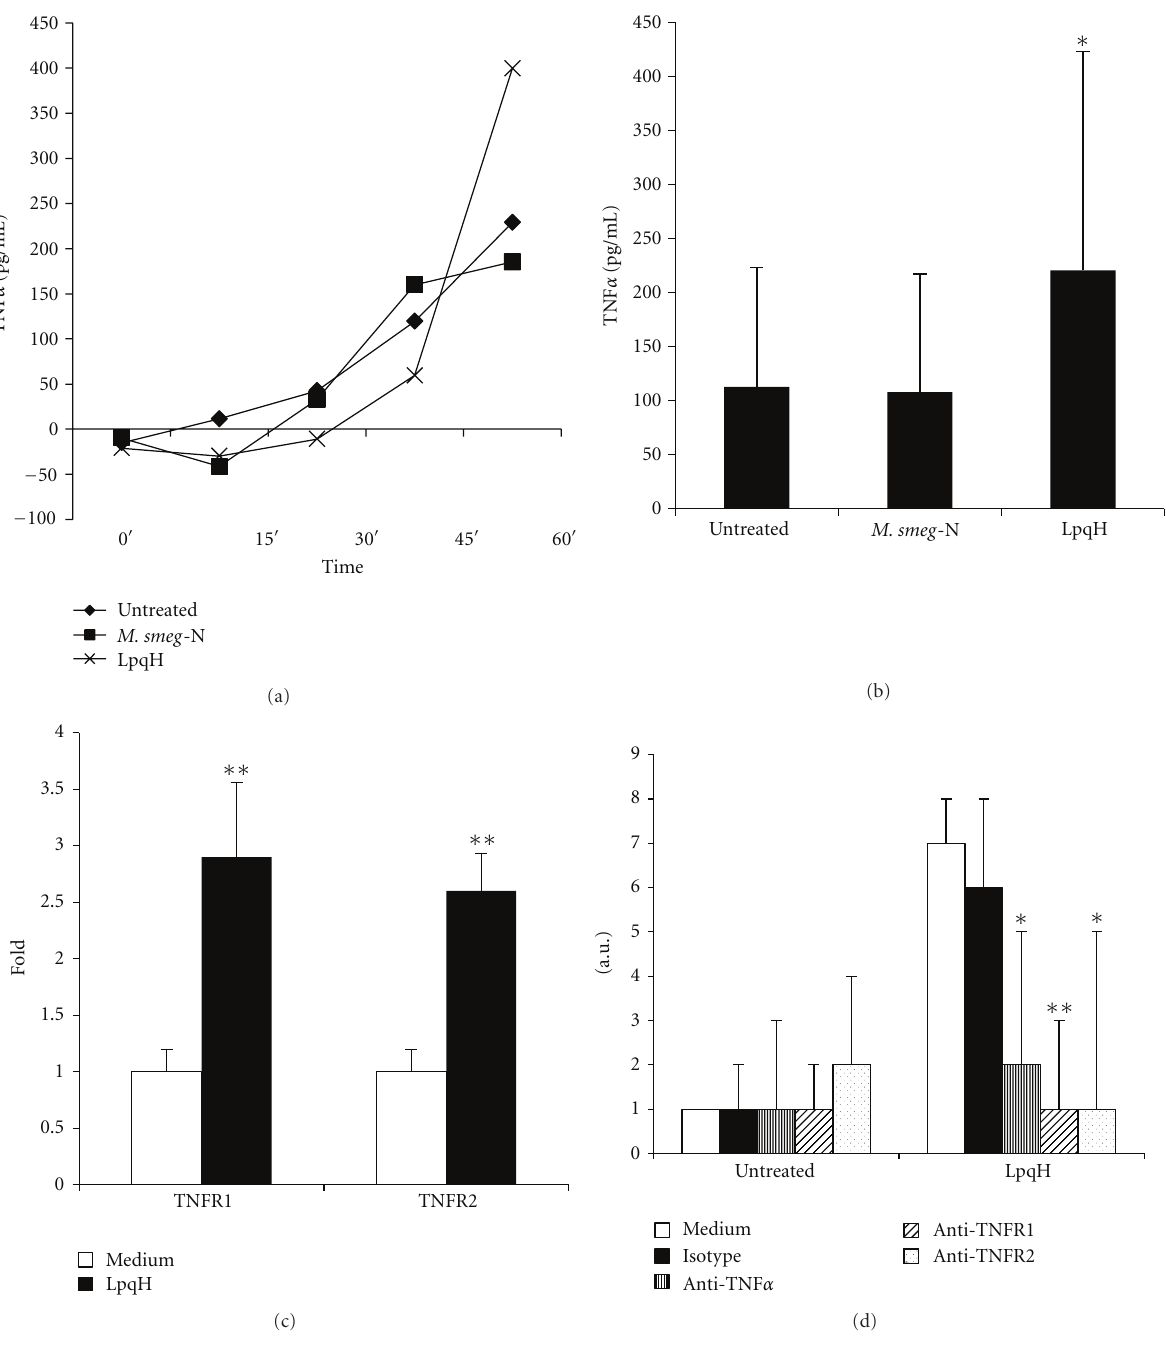
Figure 4: TNF- α and their receptors are upregulated in LpqH-promoted apoptosis. (a) MOs were incubated with 5 μ g LpqH to induce apoptosis. Control cells were incubated with 100 μ g native M. smegmatis protein ( M. smeg-N ). At indicated times the culture medium was collected and TNF- α production was quantitated by ELISA. (b) Culture media of apoptotic cells and control cells were collected at 60 min and TNF- α was measured by ELISA. Values are presented as the mean ± SE of three independent experiments; ∗ P < 0 . 05. (c) After 1 h incubation of cells with 5 μ g LpqH, the expression of TNFR1 and TNFR2 was measured by cell surface ELISA. The relative fold increase compared with untreated cells (here set to 1) is shown as the mean ± SE of three independent experiments; ∗∗ P < 0 . 01. (d) MOs were preincubated with neutralizing mAb to human TNF- α , TNFR1, and TNFR2. Thereafter, without rinsing, 5 μ g LpqH was added to cells for 1h; apoptosis was measured as described in Materials and Methods. Results are given as the mean ± SE of three independent experiments. Statistically significant di ff erences are indicated; ∗ P < 0 . 05; ∗∗ P < 0 .